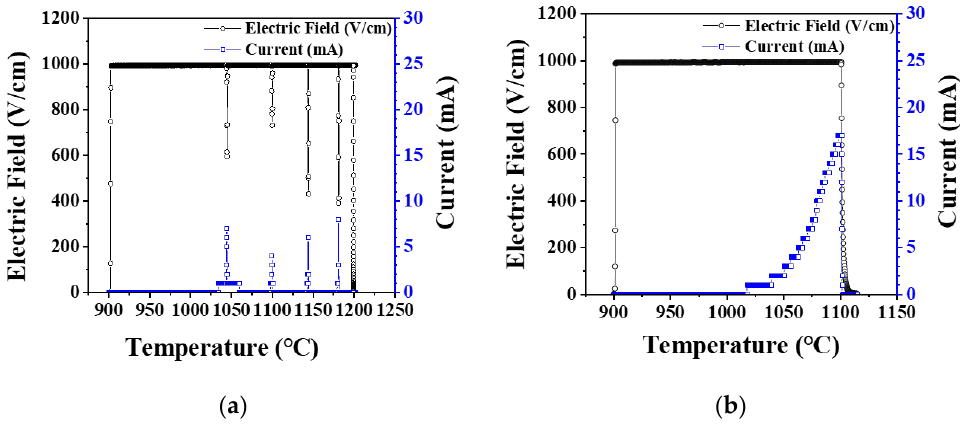
Figure 2. Electric field and current measured during flash sintering of hydroxyapatite under elevating temperature condition ( a ) in air and ( b ) in vacuum.